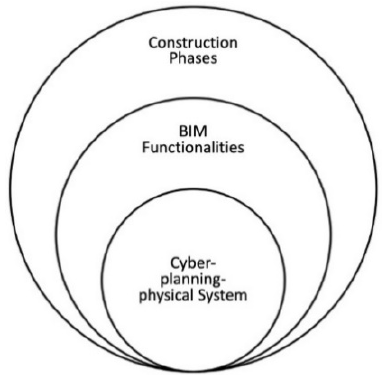
Figure 9. Relationship between cyber-planning-physical system, BIM functionalities, and construction